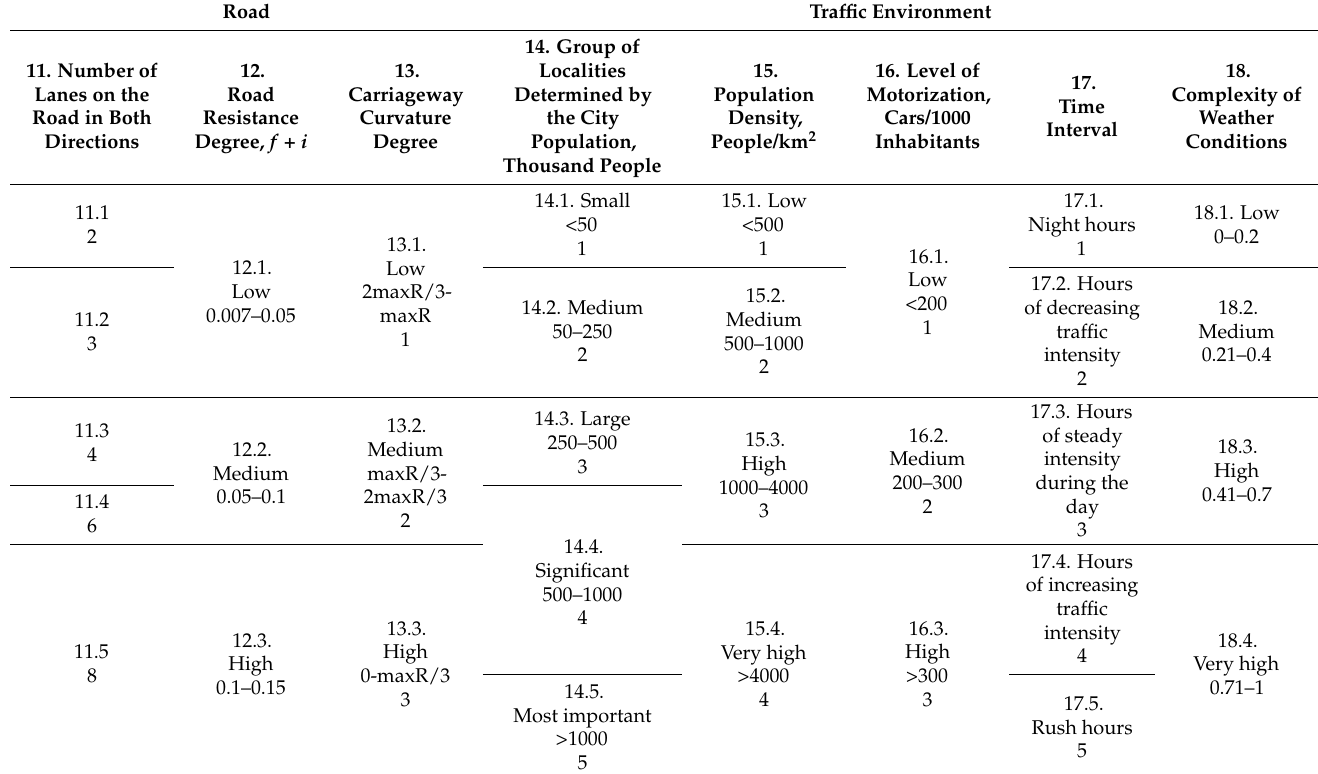
Table 2. Results of the analysis of the functional elements “Road” and “Traffic